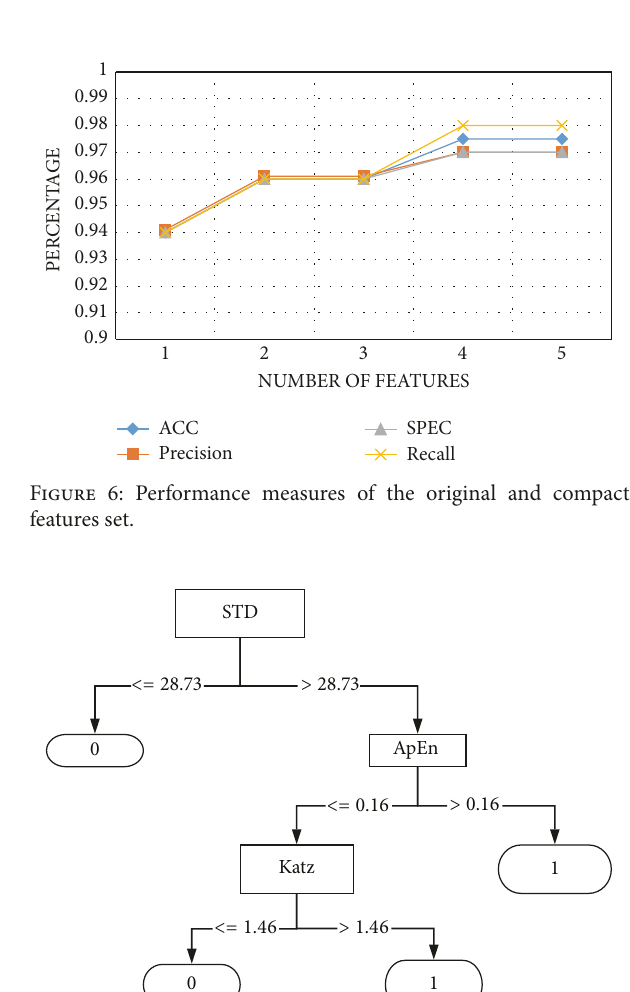
Figure 3: TQWT decomposition of seizure-free and seizure EEG signals with 𝑄 = 1, 𝑟 = 3, 𝑗 = 3 .